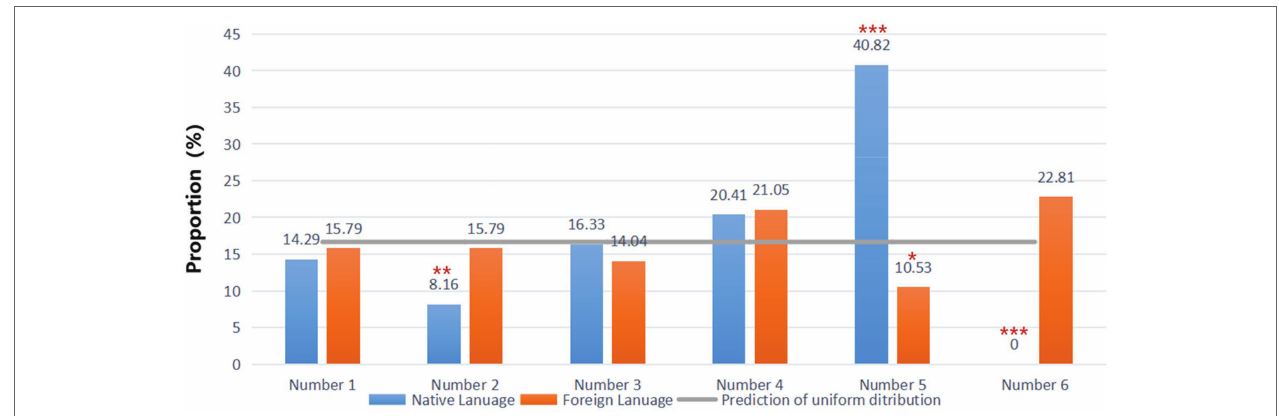
FIGURE 1 | Percentage of reported number of participants by groups. Stars display the significance of two-sided binomial test that the observed percentage differs from 16.7%; * 10% level, ** 5% level and *** 1% level.